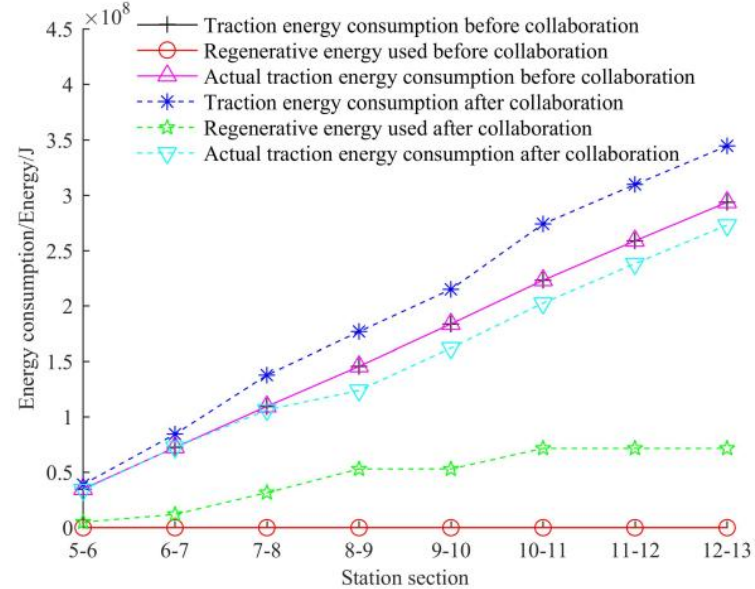
Figure 8. Energy consumption simulation diagram of Train 1.